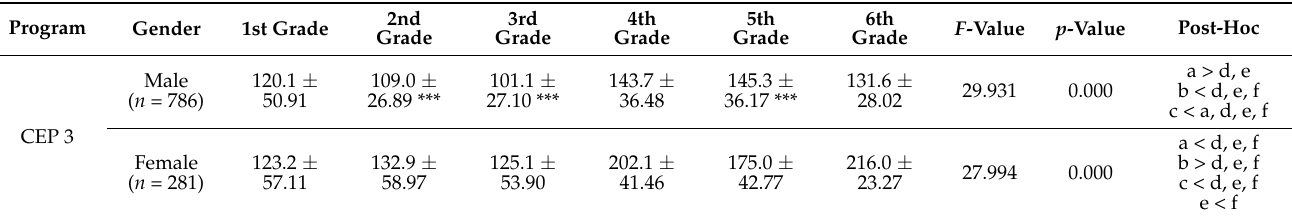
Table 5. Comparison of circuit exercise program by grade and gender ( Mean ± SD